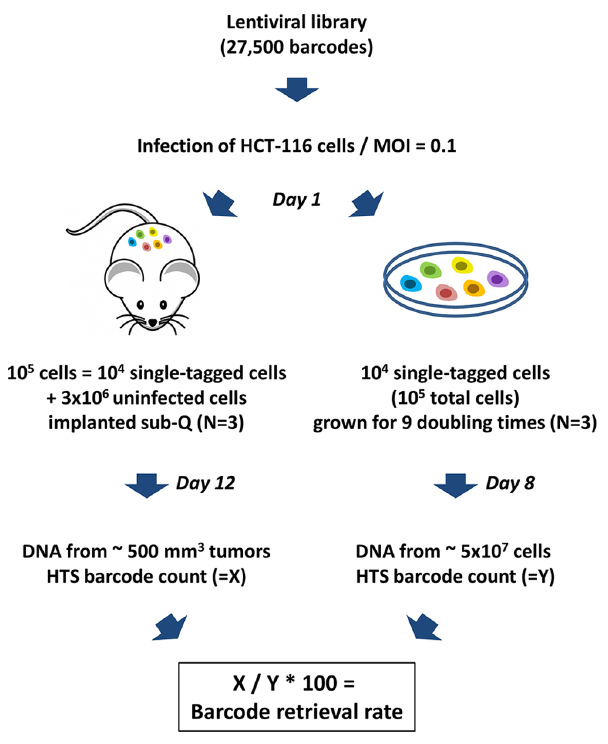
Figure 1. Tracing individually-labeled HCT-116 cancer cell clones invitro and invivo. A lentiviral library containing 27,500 unique barcodes was used to transduce HCT-116 cells at an MOI of 0.1. Pools of 10 5 cells, corresponding to 10 4 individually tagged cells were either admixed with 3 6 10 6 cells and implanted subcutaneously into NSG mice or grown in culture in vitro . Cells were harvested after 9 days and tumor removed after 12 days, and total DNA preparations from cells or tumors were subjected to the barcode retrieval procedure.